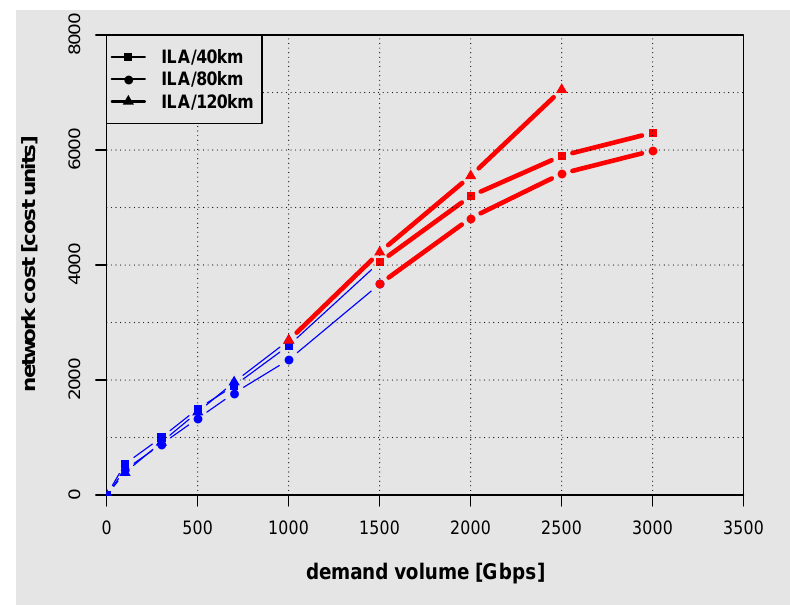
Figure 8. The dependence of network cost on the demand volume for American network.